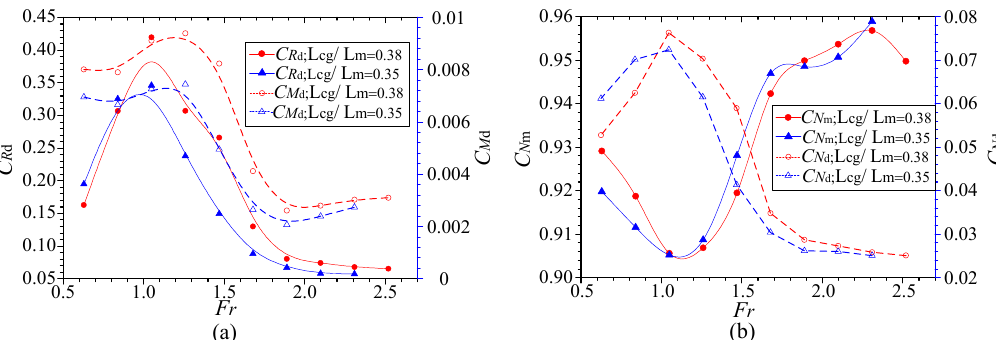
Figure 24. Forces and moment acted on the hull in the TFS at different speeds: ( a ) resistance and moment of the side-hulls;